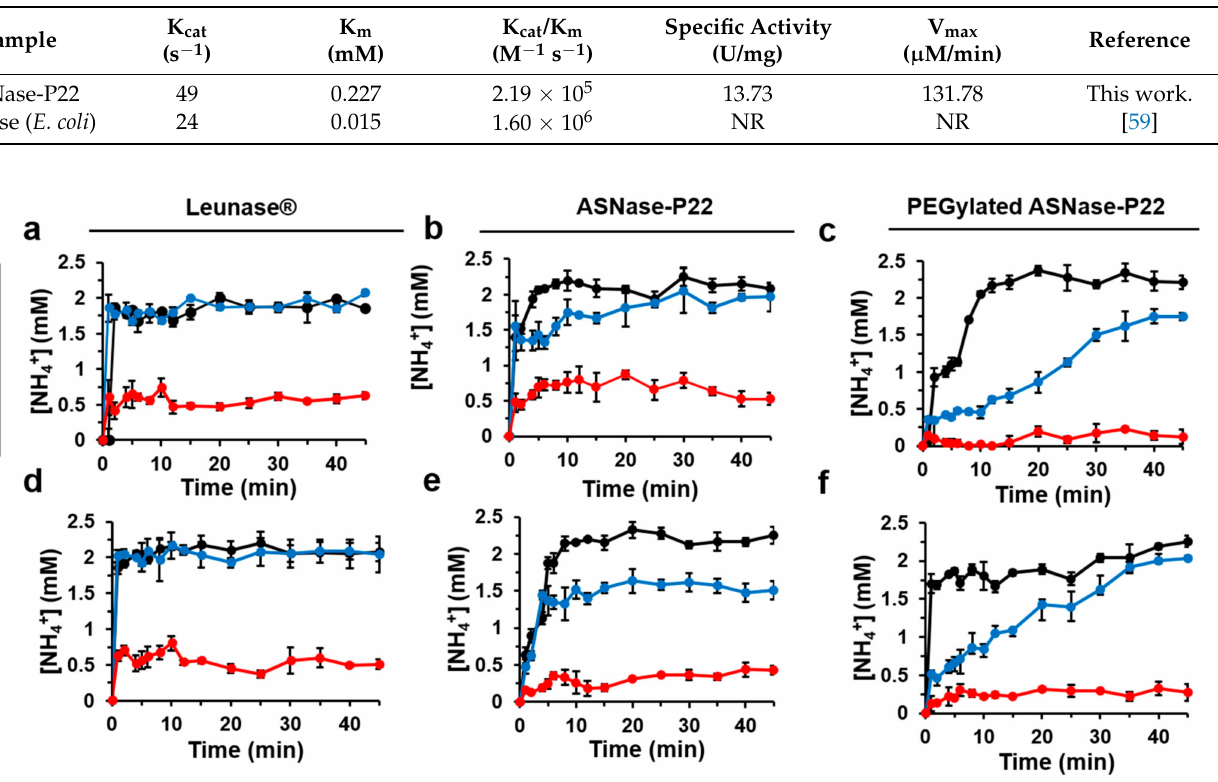
Figure 7. Enzymatic activity of ASNase-P22 nanoreactors in the presence or absence of human blood serum (HBS) at different incubation time at 37 ◦ C. Control conditions without HBS. ( a ) Leunase ® , ( b ) ASNase-P22, and ( c ) PEGylated ASNase-P22. ( d ) Leunase ® +20% HBS, ( e ) ASNase-P22 +20% HBS, and ( f ) PEGylated ASNase-P22 +20% HBS. ASNase-P22 nanoreactors contained 10% glycerol. Black, 0 h; blue, 24 h; red, 48 h. ( n = 3). Error bars represent the standard